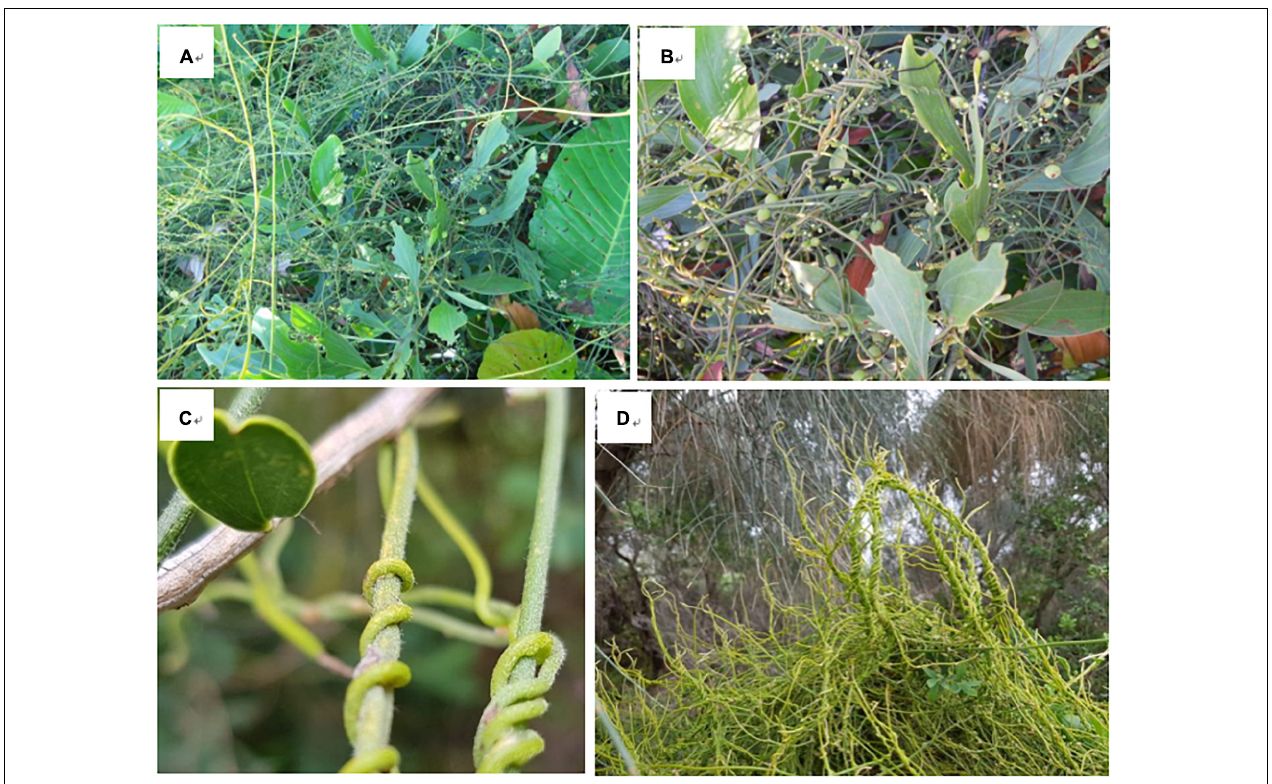
FIGURE 1 | Images of Cassytha filiformis ( A,B , in Brunei) and Cassytha pubescens ( C,D , in Australia) on host species (source: